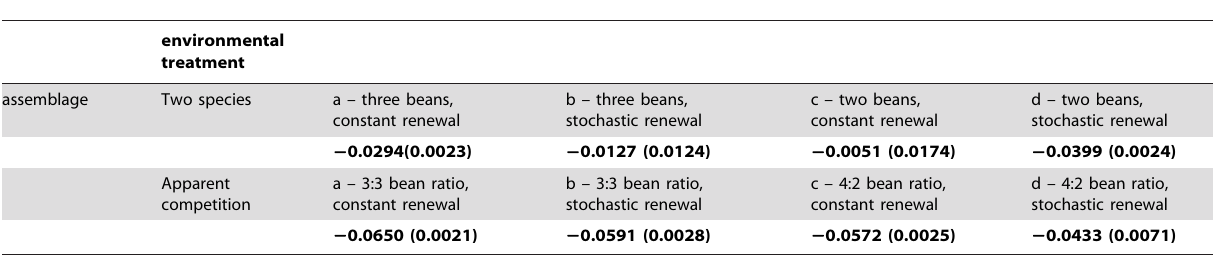
(cid:4) (cid:5) , in host population dynamics. r